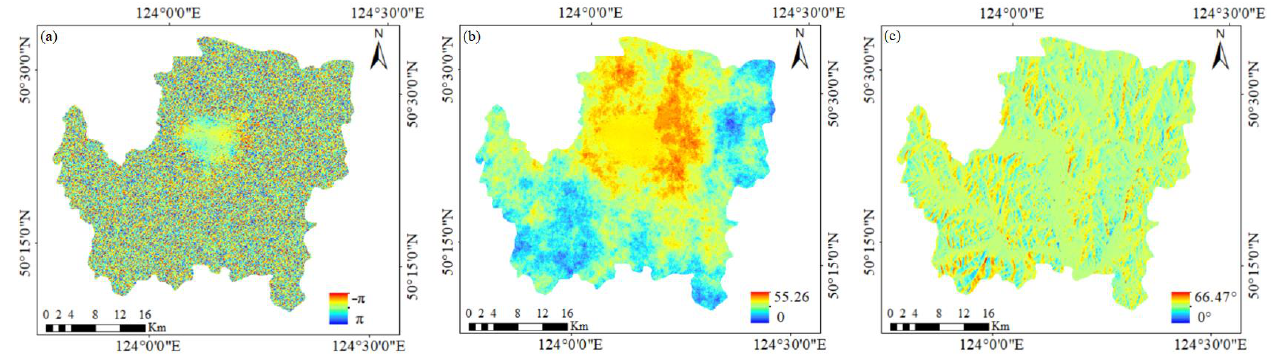
ation method is Minimum Cost Flow (MCF). The phase unwrapping results are shown in Figure 8b. If the phase unwrapping is performed in the Windows environment, Snaphu needs to be invoked through PowerShell. For range Doppler terrain correction of the image used in this paper, the pixel spacing was set to 30 m, the reference system was WGS84, the map projection was UTM 51N and the resampling method was based on bi- linear interpolation. The obtained local incident angle information is shown in Figure 8c.